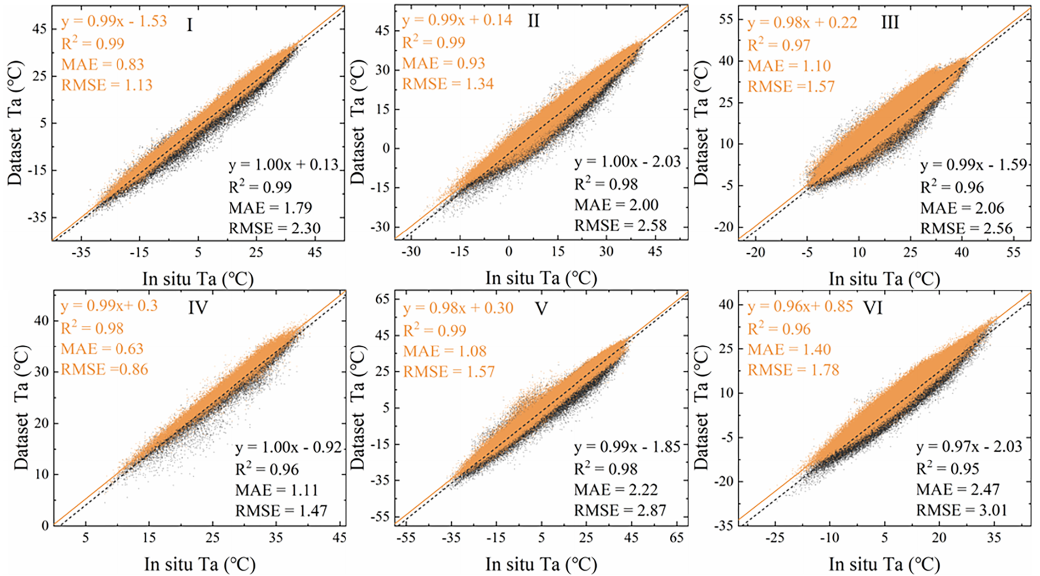
Figure 9. Scatter diagrams of the original T max and reconstructed results versus their corresponding ground station data in six natural subregions (I, II, III, IV, V, and VI). Gray points indicate low-quality pixel values in the original T max data, orange points represent the values in the after-calibration T max dataset; the statistical accuracy measures ( R 2 , MAE, and RMSE) are also